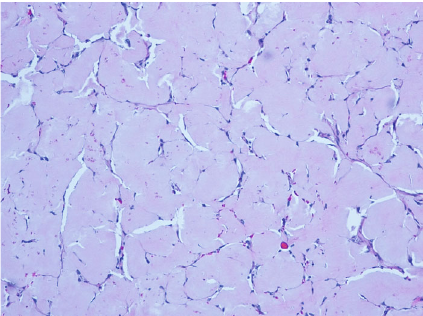
Figure 4: Gel demonstrating features typical of ORISE ™ with associated in fl ammation identi fi ed in additional sections. H and E stain ×